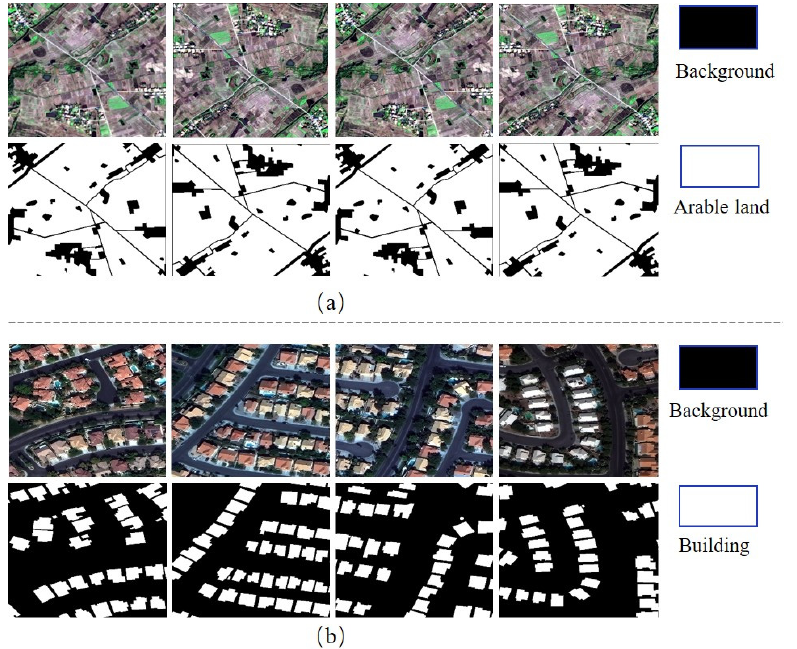
Figure 9. Sample images and labels from both the ZY-3 dataset ( a ) and the DeepGlobe dataset ( b ).